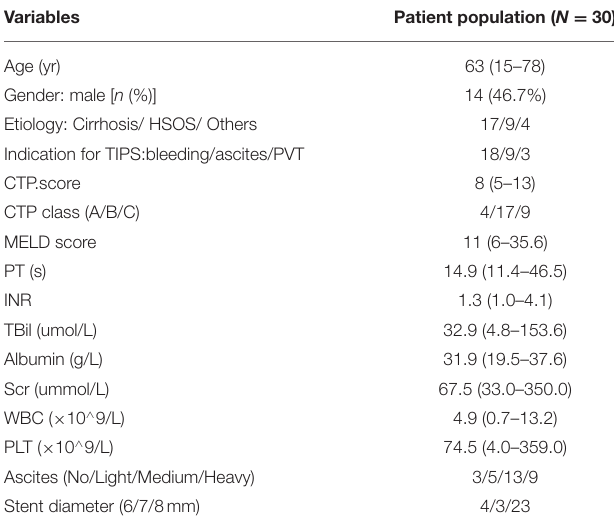
(3.2%) patients. Technical-related major complication rates every year were 2.6 (3/113), 2.7 (4/148), 4.3 (6/138), 5.4 (9/164), 2.4 (5/207), and 1.7% (3/174) from 2015 to 2020, respectively. Patients’ baseline characteristics are shown in Table 1 . Seventeen patients received TIPS for liver cirrhosis, and 9 for HSOS, and 4 for Budd-Chiari syndrome. The major complications included hemobilia, hemoperitoneum, accelerated liver failure, and rapidly progressive organ failure ( Table 2 , Figure 1 ). Eight patients (0.84%) died because of major complications. Hemobilia Thirteen (1.37%) patients developed hematemesis, abdominal pain, and obstructive jaundice after TIPS owing to biliary injury during the procedure, including 10 patients with liver cirrhosis and 3 cases with HSOS. Only 3 patients recovered with conservative medicine treatment. Eight patients underwent endoscopic retrograde cholangiography (ERCP), bile duct cleaning, and nasobiliary drainage ( Figure 2 ); one patient underwent percutaneous transhepatic biliary drainage, and 1 patient underwent hepatic artery embolization. Finally, one patient died because of continuous